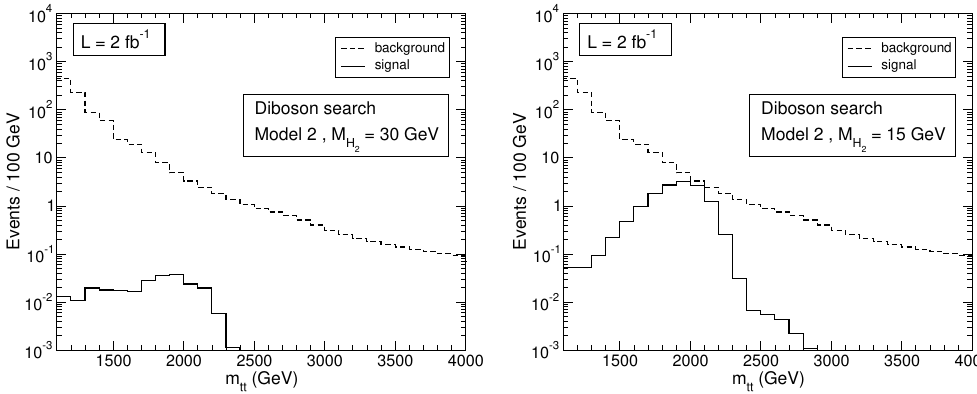
Figure 10 . Invariant mass distribution for the Z 0 signals and their backgrounds in the diboson analysis, for and alternative scenario 1 of model 2 with M H